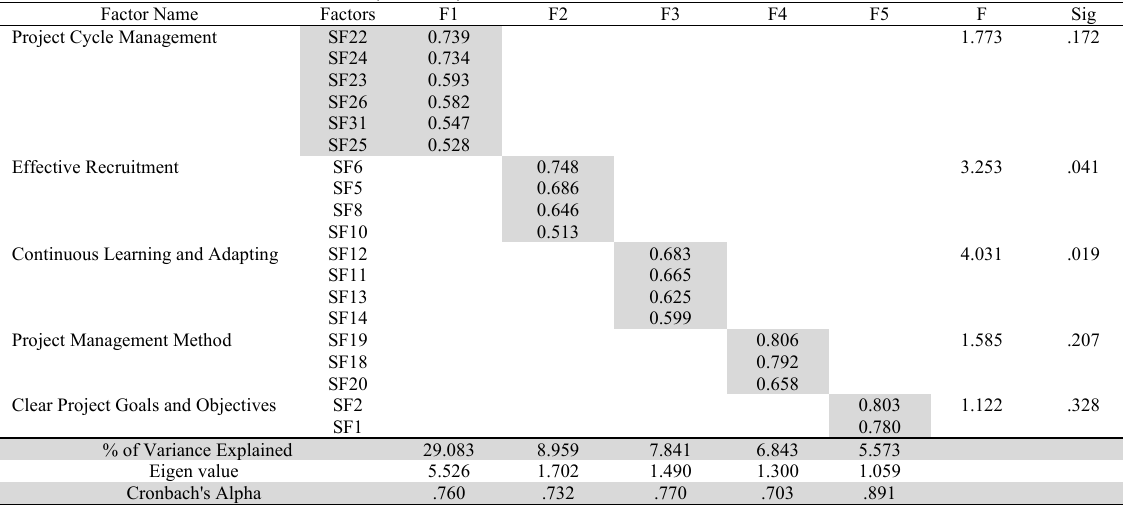
Results of EFA and ANOVA for CSFs (N =